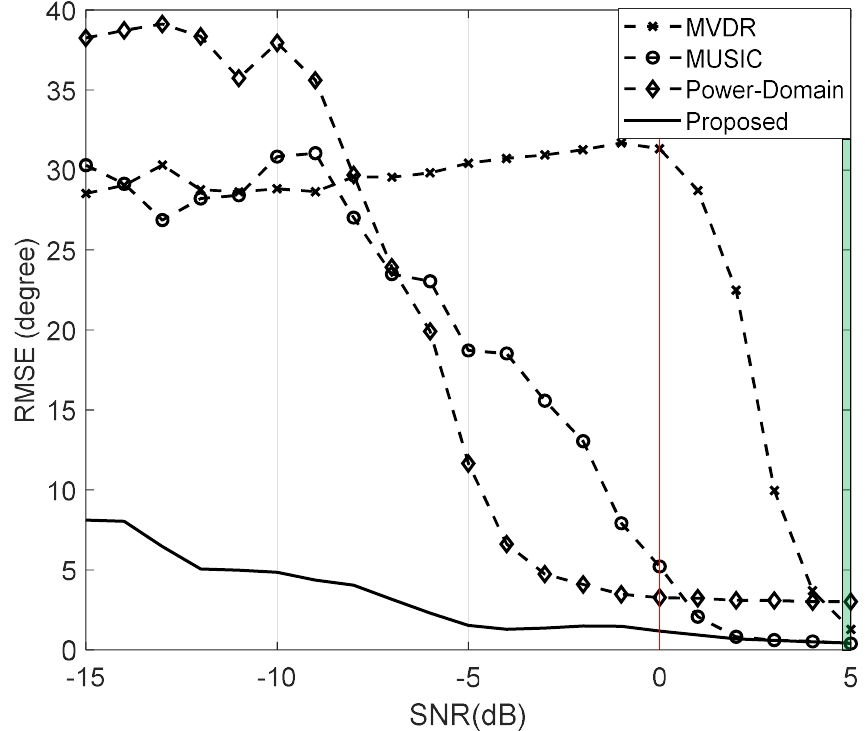
Figure 4. RMSE versus snapshot for the different estimators (MUSIC, MVDR, Power-Domain, and the proposed estimator) in Example 2.